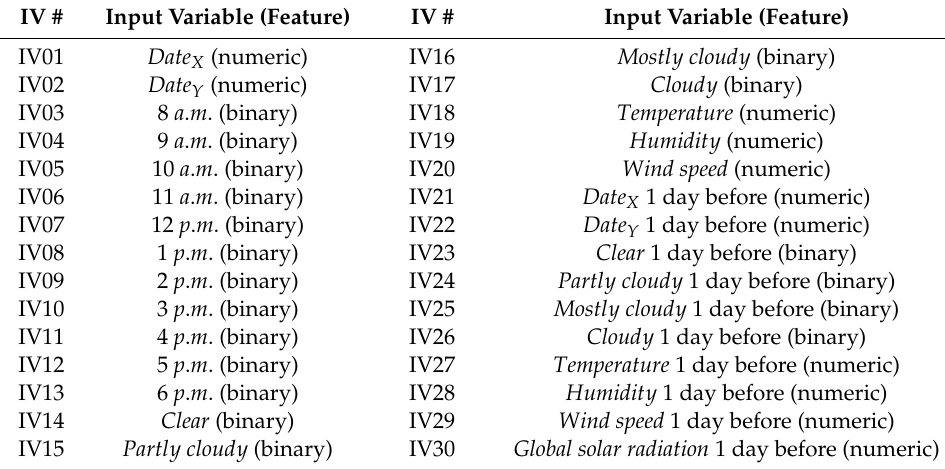
Table 1. List of input variables (IV) for the proposed